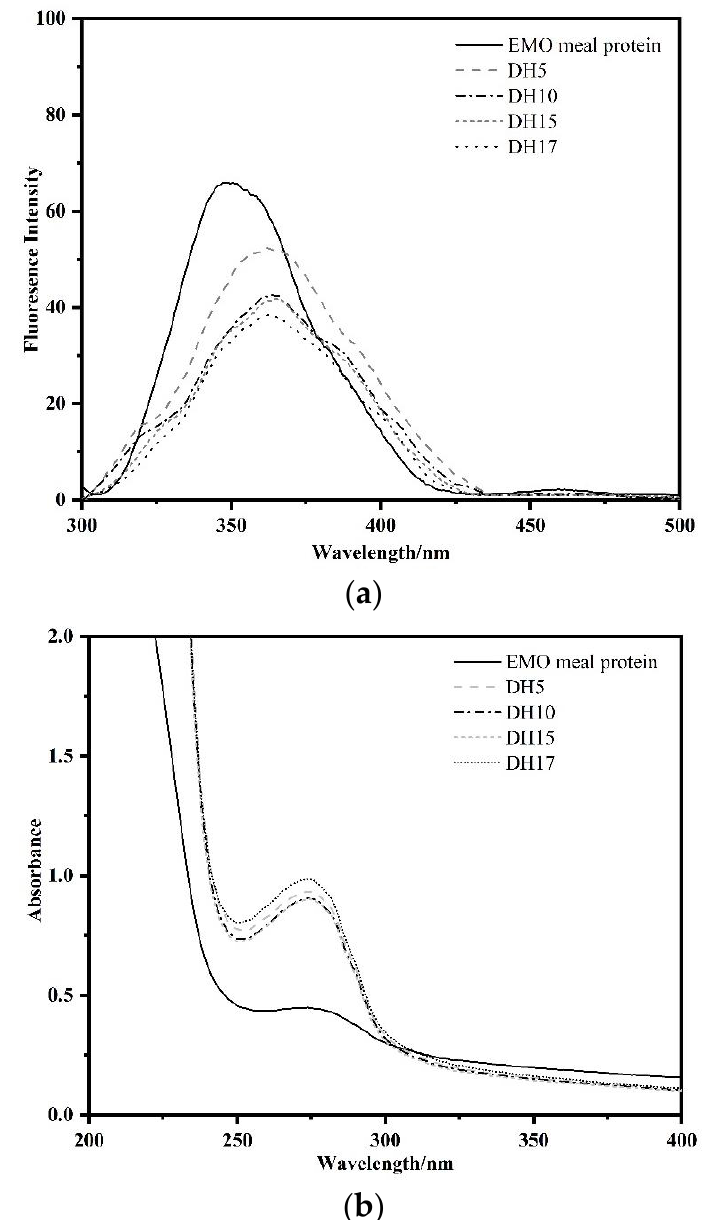
Figure 4. Changes in intrinsic fluorescence ( a ), and ultraviolet spectra ( b ) of EMO meal protein and hydrolysates with different DH.